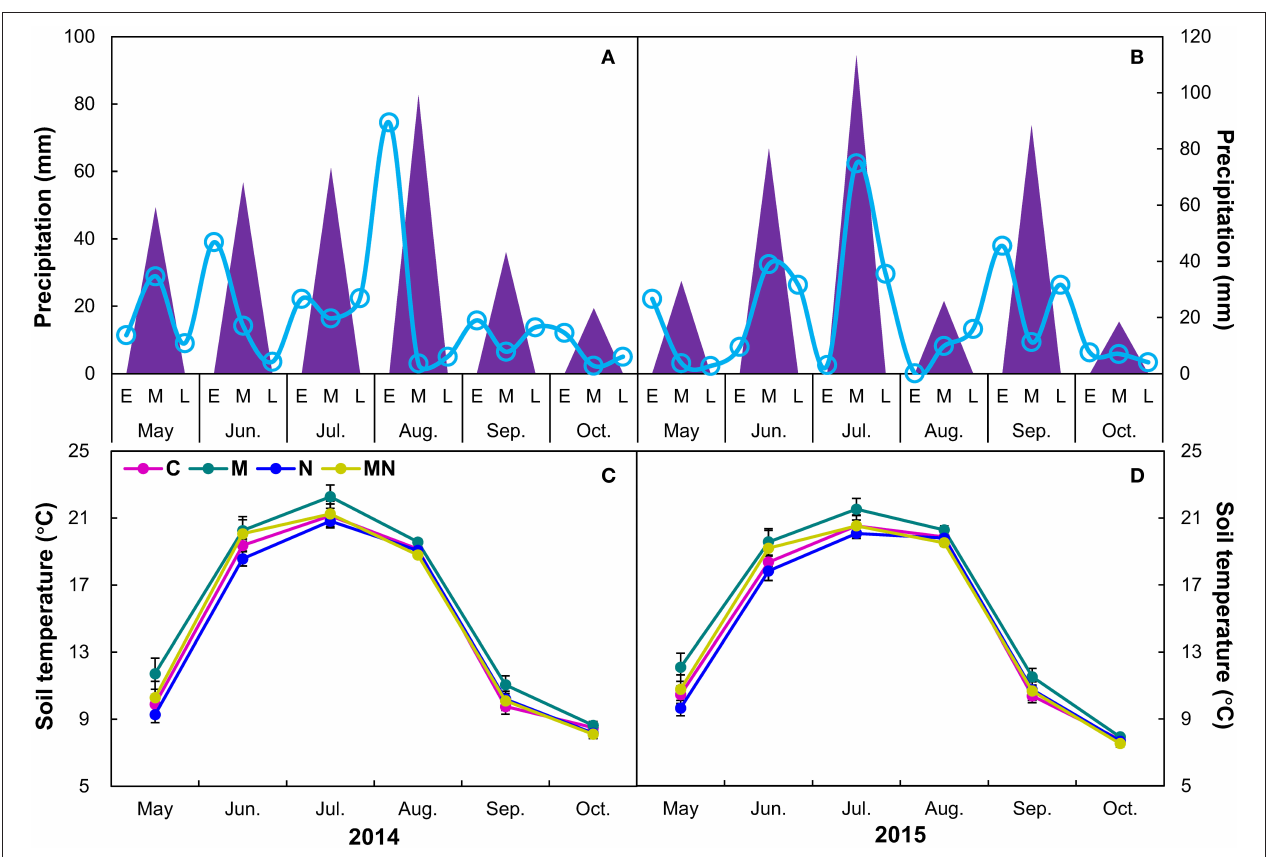
FIGURE 1 | Precipitation (mm) in each month (triangles) and in the early (E), middle (M), late of each month [L, smooth lines (A,B) ], and effects [Mean ± 1 SE (C,D) ] of mowing and nitrogen addition on monthly soil temperature during each growing season from 2014 to 2015. C, control; M, mowing; N, nitrogen addition; MN, mowing plus nitrogen addition.